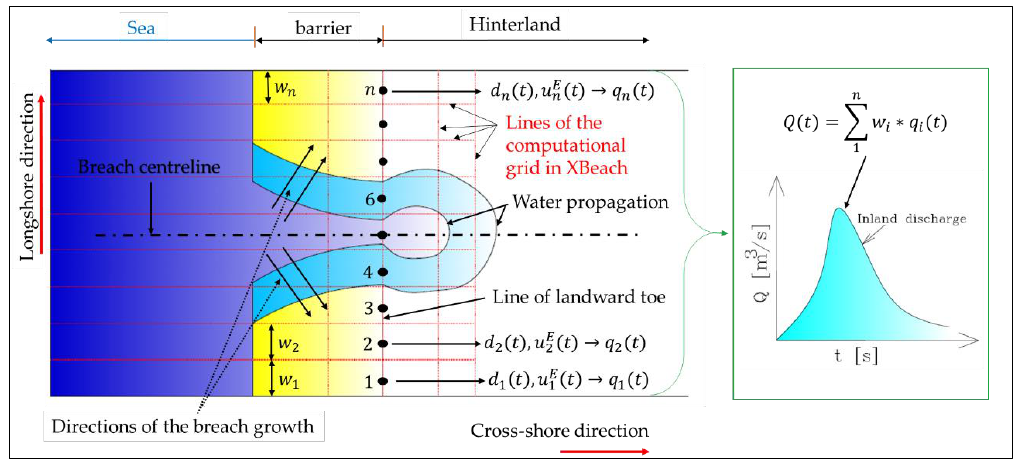
Figure 13. Approach for the calculation of the inland water discharge Q(t) through a breach using XBeach, n = number of longshore stretches, w i represents stretches’ widths, d i and u iE are the local water depth and Eulerian velocity at dune’s landward toe of each stretch (schematic).